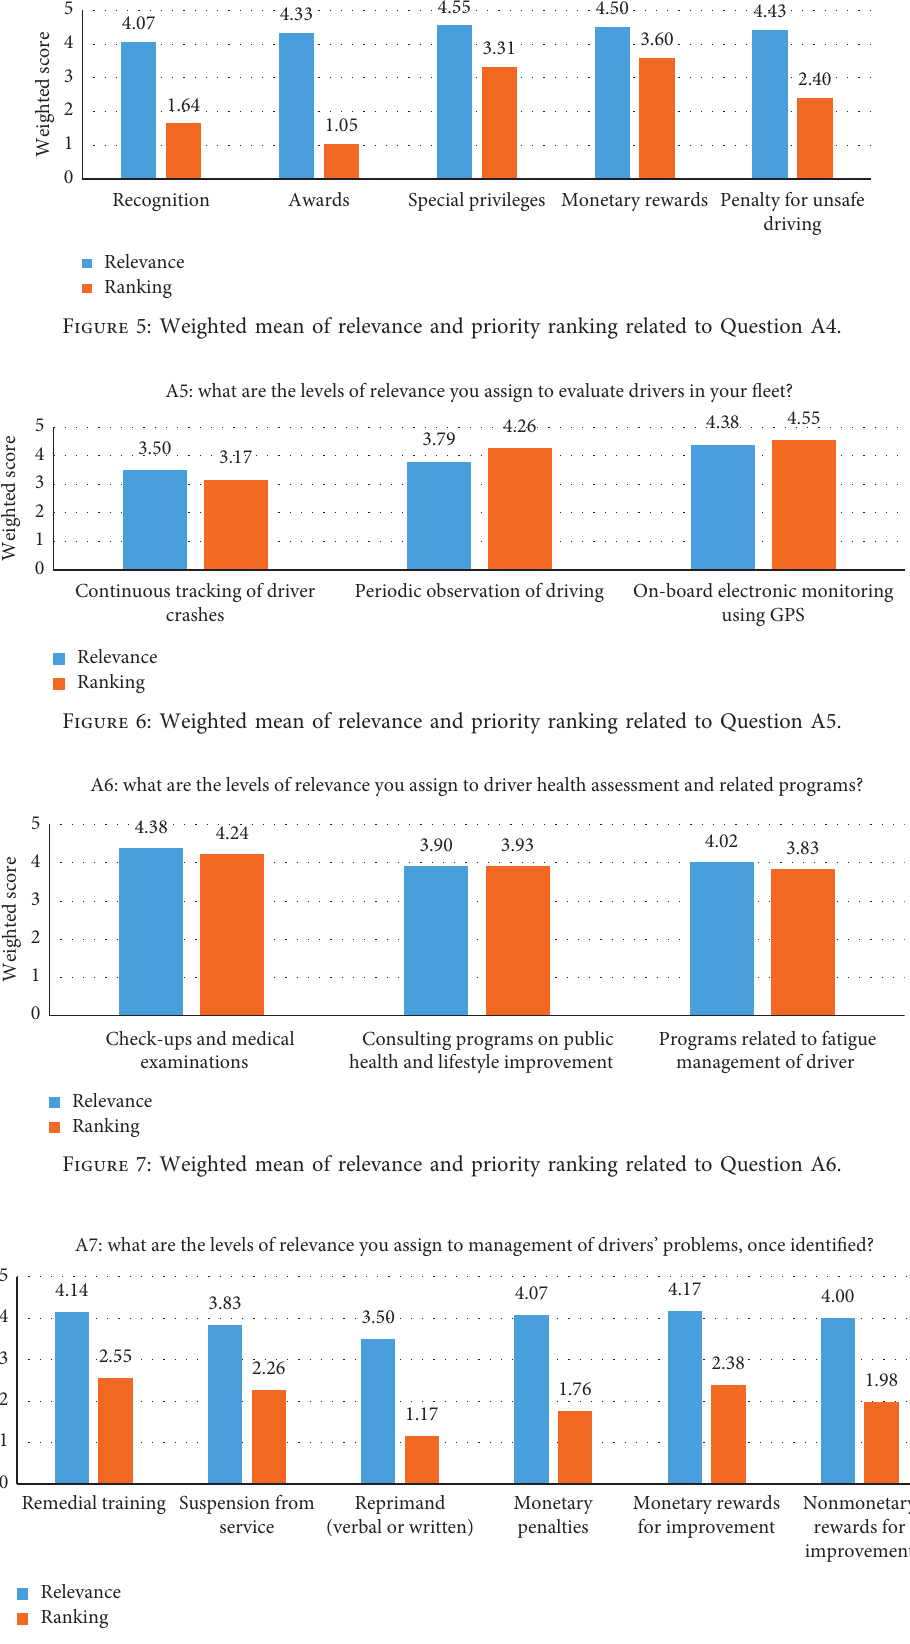
Figure 8: Weighted mean of relevance and priority ranking related to Question